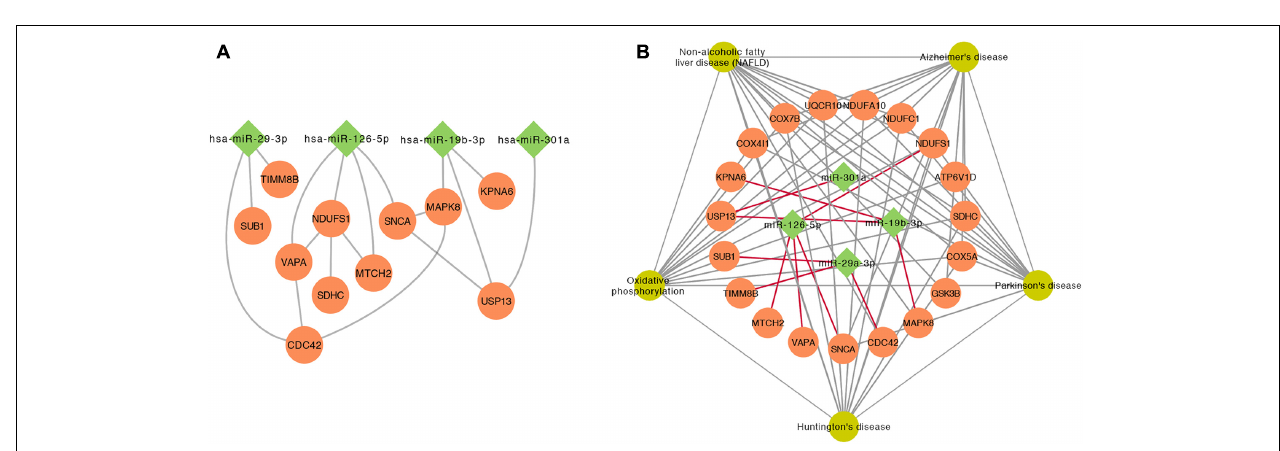
FIGURE 5 | The interaction between miRNAs and genes. (A) The relationship of gene–gene and gene–miRNA. (B) The outline of the interaction between the significant KEGG pathways of meta-DE genes and miRNAs.